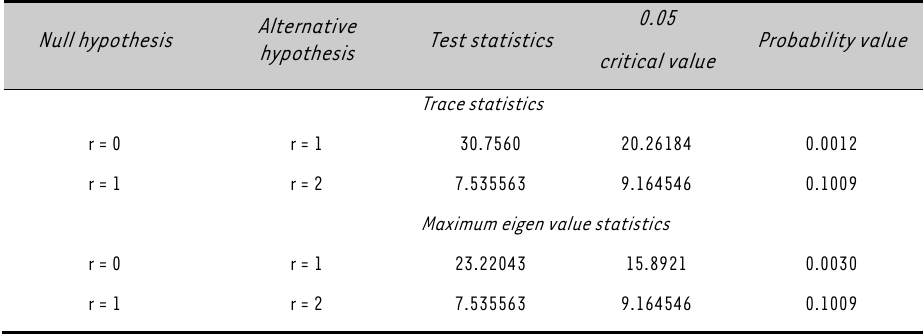
Cointegration test results between LNGDP and LNPC